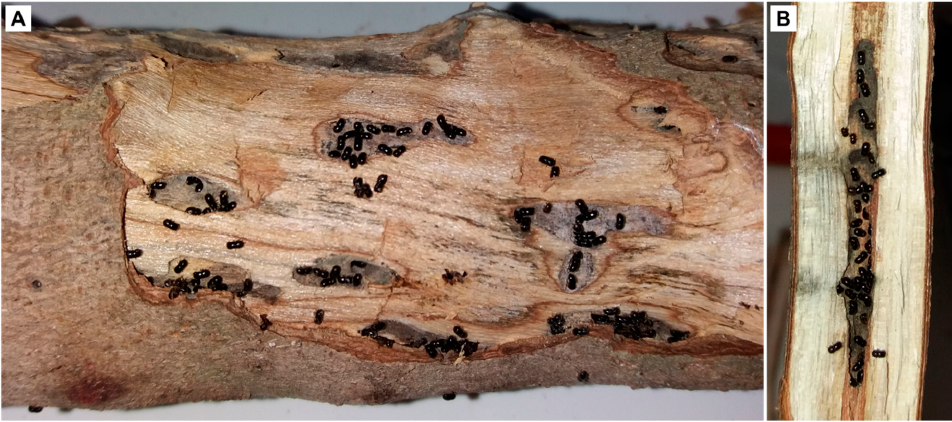
Figure 3 . Xylosandrus compactus adults in several galleries of a Carob branch ( A ) and typical galleries inside a Carob twig ( B